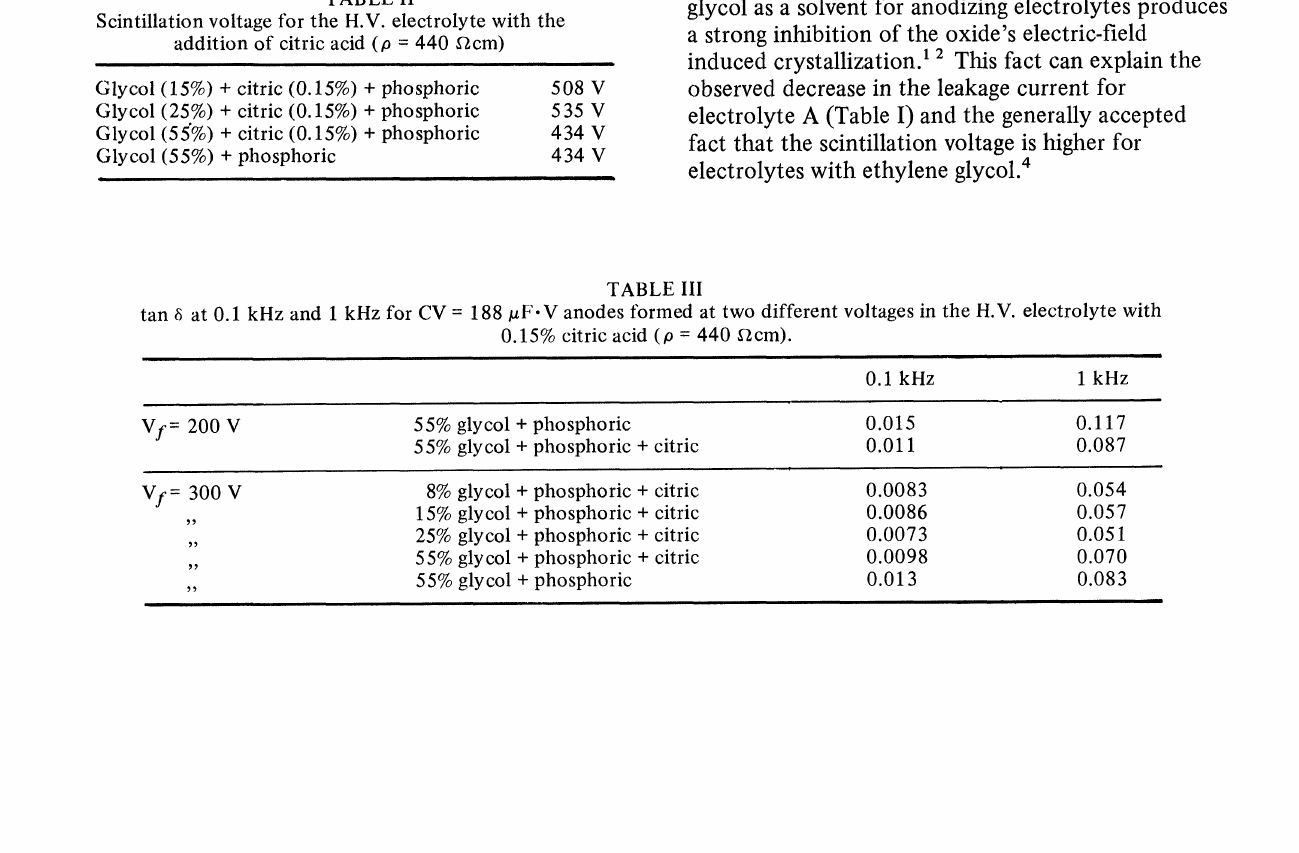
TABLE II Scintillation voltage for the H.V. electrolyte with the addition of citric acid (o 440 s2cm)